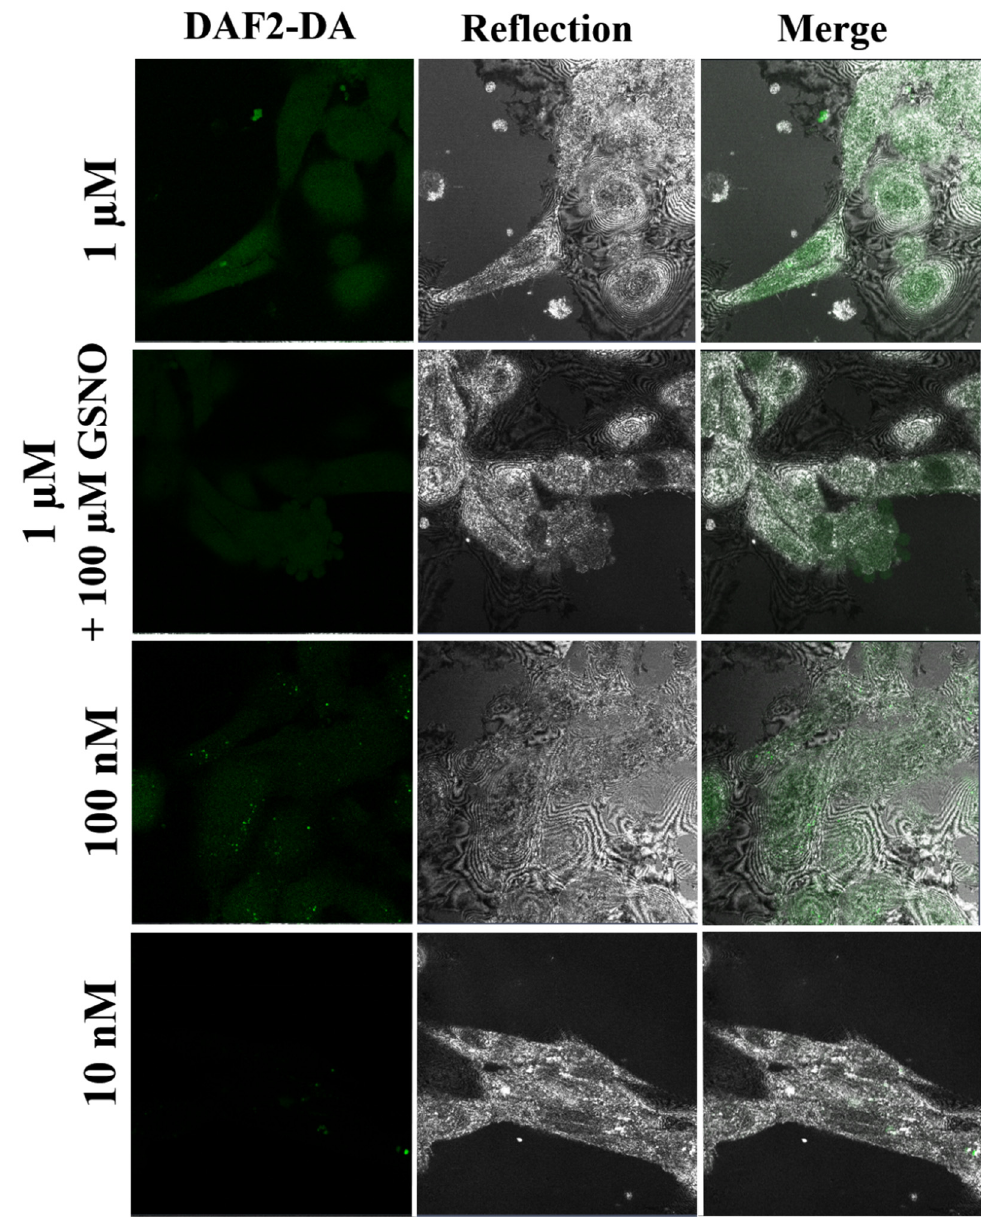
Figure 7. Representative CLSM images of intracellular NO detection by the DAF2-DA in HUVEC cells using much lower concentrations (1 µ M, 100 nM, and 10 nM) of the DAF-2DA than the standard protocol (10 µ M) in fluorescent (left panel) reflected mode (middle panel) and merged (bottom panel). Confocal laser scanning microscopes (CLSM) with a water immersion objective Zeiss 40 × /NA 1.2 were applied.